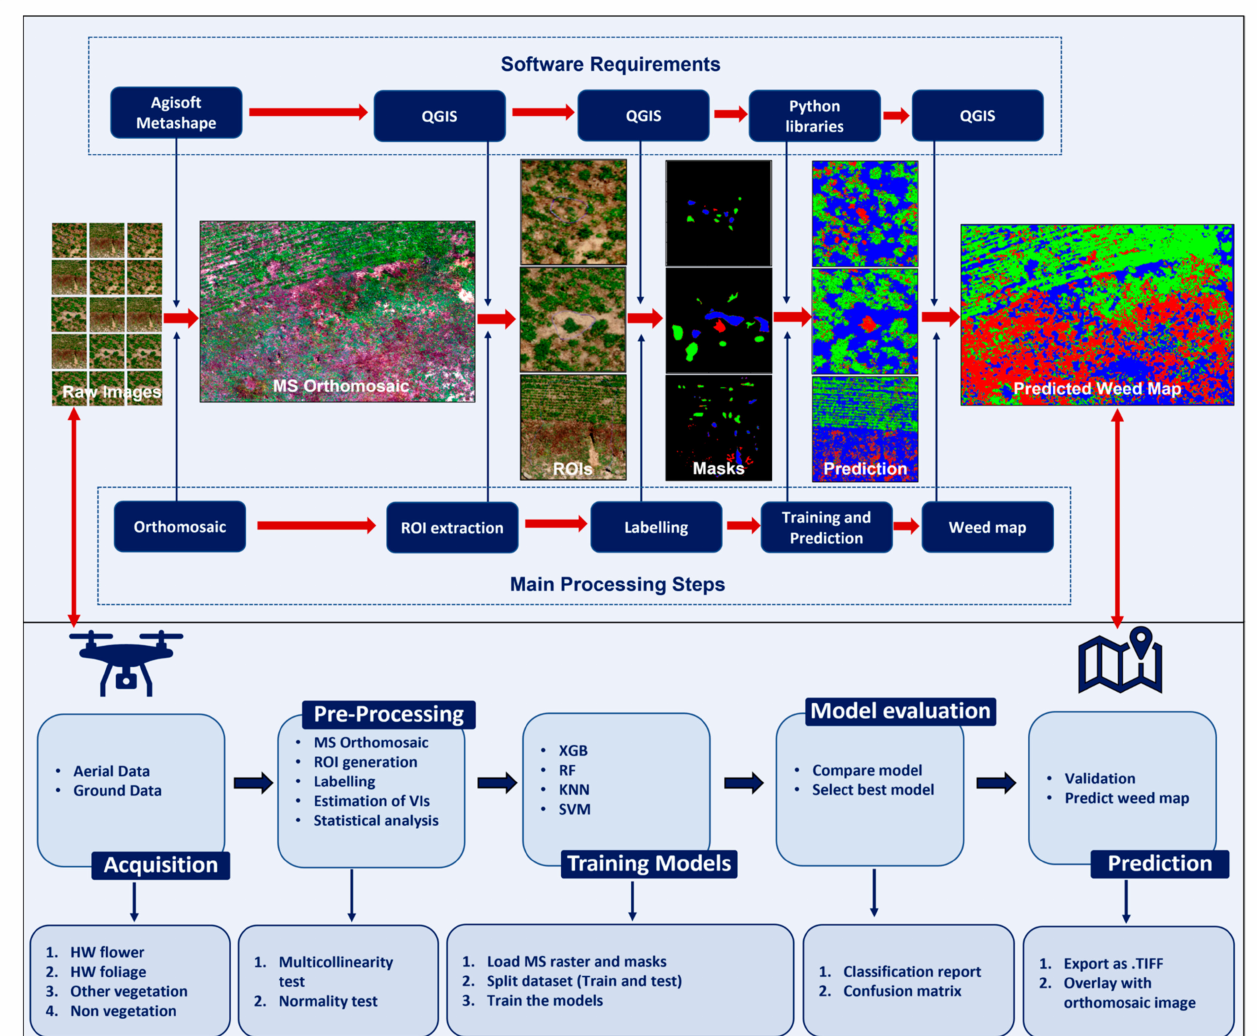
Figure 6. UAV-acquired multispectral imagery processing pipeline for detection